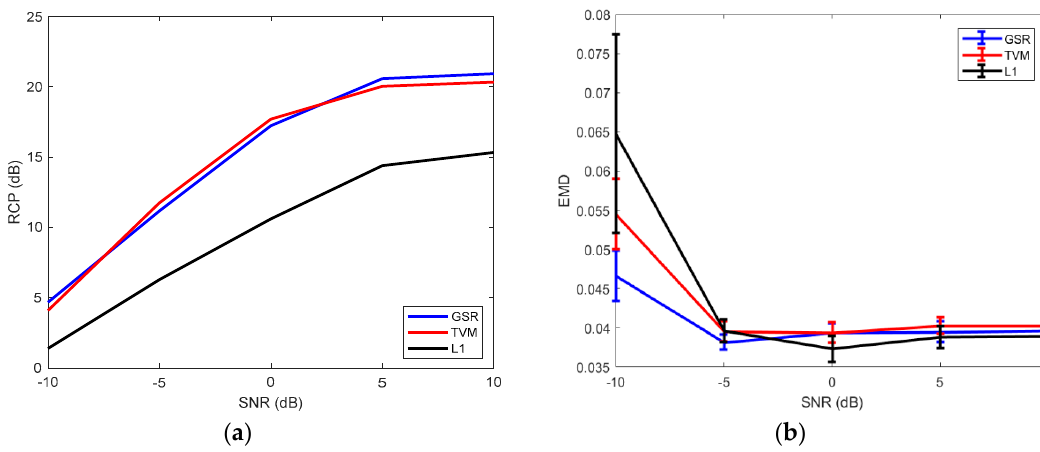
Figure 6. Quantitative Metrics vs. SNR for three-targets scene reconstruction using two transmitters